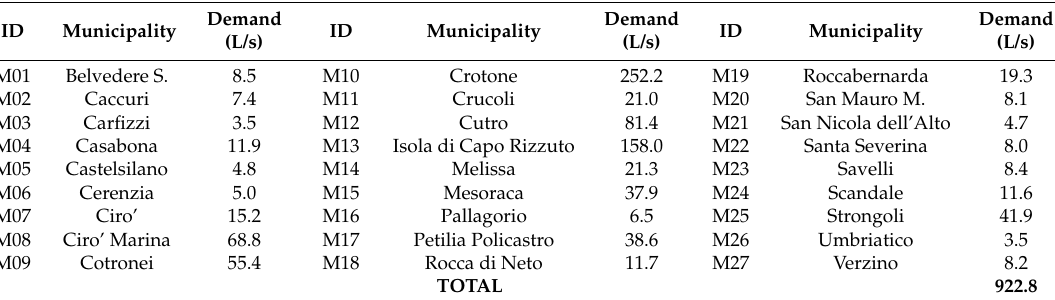
Table 2. Destination nodes in the province of Crotone.